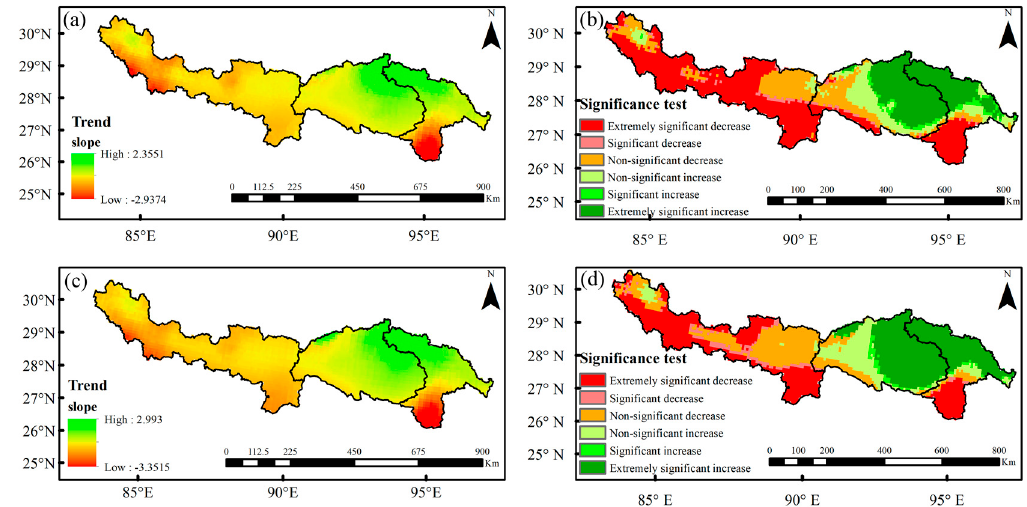
Figure 14. Annual ( a, b ) and growing season ( c, d ) spatial variation trends of the soil water content with the significance test.